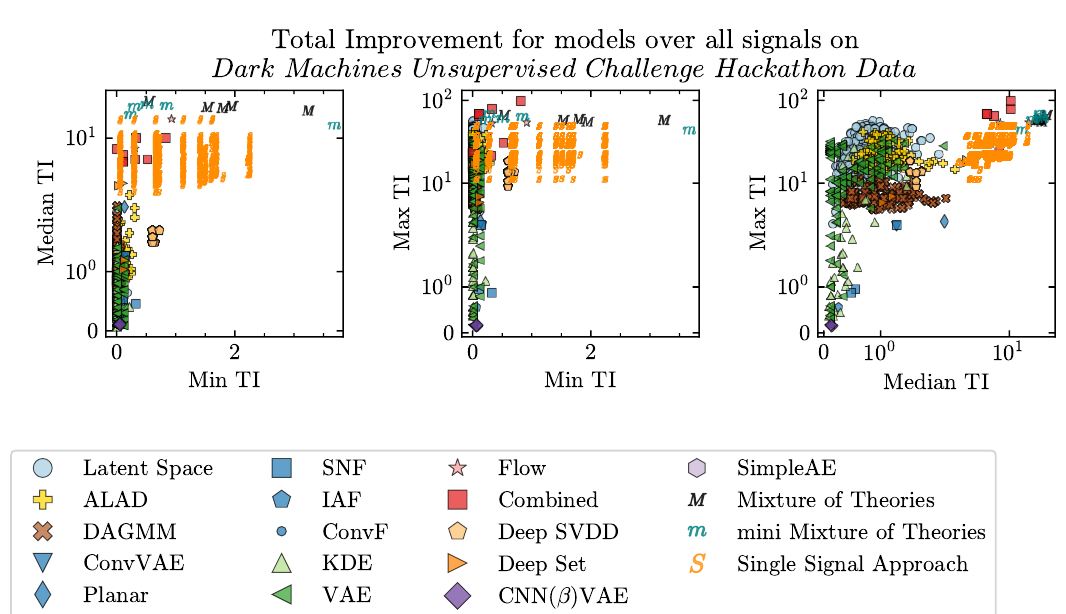
Figure 3 . The figure shows the results for the total improvements of Dark Machines hackathon data comparing the supervised methods and the unsupervised methods. There are a total of 2401 SSA models denoted as S , 5 MoT models trained on all signals denoted as M , and 5 mini MoT models trained on a randomly selected subset of the signals denoted as m